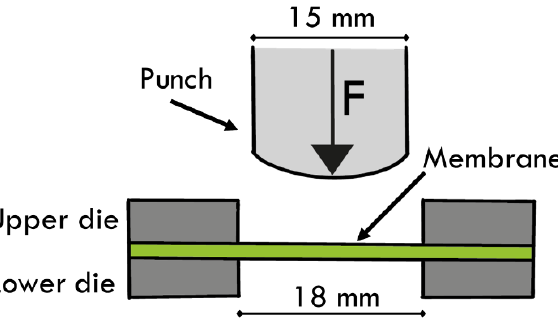
Figure 1 . Small punch test configuration. Figure 1. Small punch test configuration.